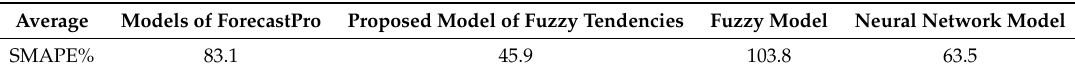
Table 10. ForecastPro results for predicting short non-stationary time series over 6 intervals compared to fuzzy models and a neural network